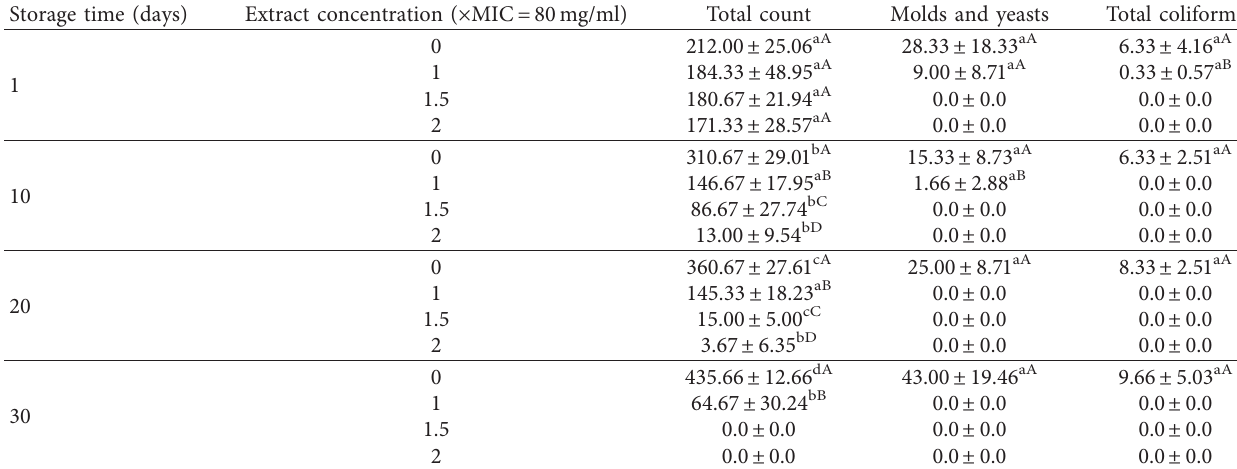
Table 4: Antibacterial effects of different concentrations of pomegranate peel aqueous extract incorporated in coatings of emergency food product during 30 days of